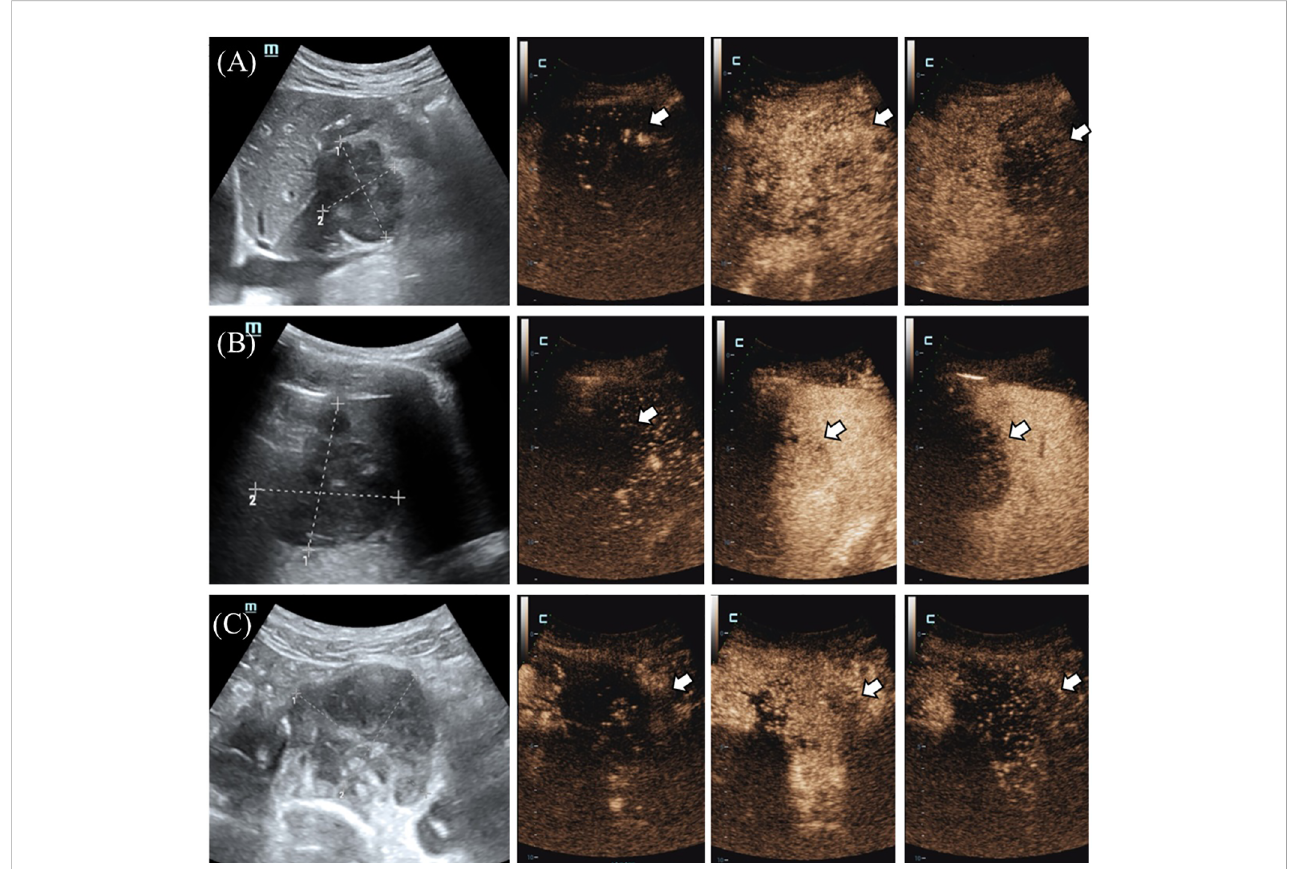
FIGURE 2 (A) The tumor in the hilar region showed thickened blood vessels, located at the edge of the tumor (indicated by the arrow), and was enhanced and cleared earlier than the surrounding tissue. (B) The splenic mass (shown by the arrow) showed a peripheral to central enhancement pattern with uneven hypoenhancement, which was enhanced later and cleared earlier than normal splenic tissue. (C) In the presacral mass (shown by the arrow), the central vessels of the mass were enhanced fi rst, and the enhancement began later than the peripheral tissues, with uneven hypoenhancement, and there were obvious fi lling defects, and the clearance was earlier than the peripheral